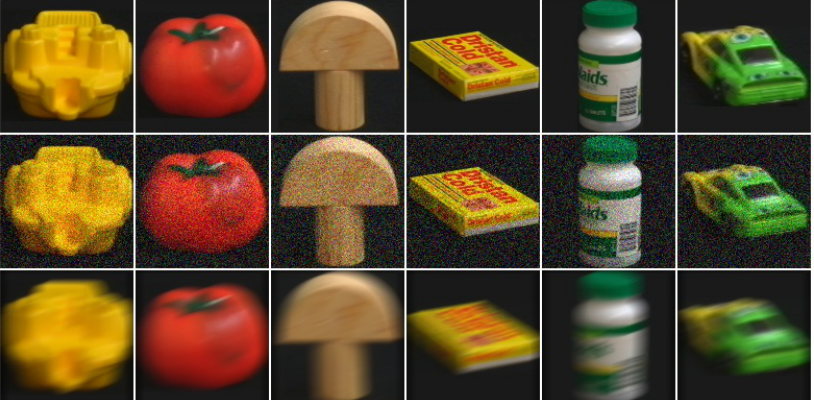
Figure 2. Test image examples from COIL-100 without noise ( first line), with additive Gaussian noise ( middle line), and with strong motion blur ( bottom line).